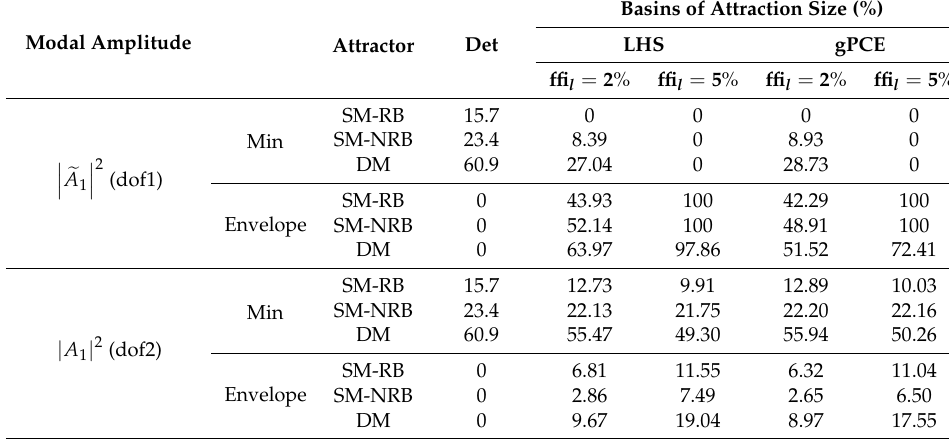
Figure 10. Envelopes of the attractors of ( a ) SM-RB, ( b ) SM-NRB and ( c ) DM of the modal intensity amplitude |(cid:1827) (cid:2869) | (cid:2870) of the second pendulum response, in the Nyquist plane (((cid:1853) (cid:2869) ) (cid:2868) ,((cid:1854) (cid:2869) ) (cid:2868) ) for (cid:2026) = −1 and ((cid:1853) (cid:2870) ) (cid:2868) = ((cid:1854) (cid:2870) ) (cid:2868) = 0.25 , computed using the gPCE method for (cid:2012) (cid:3039) = 5% . Table 3. Comparison of the contributions of the attractors of SM-RB, SM-NRB and DM in the basins of attraction computed using the LHS and gPCE methods, for deterministic case (det), (cid:2012) (cid:3039) = 2% and (cid:2012) (cid:3039) = 5% .